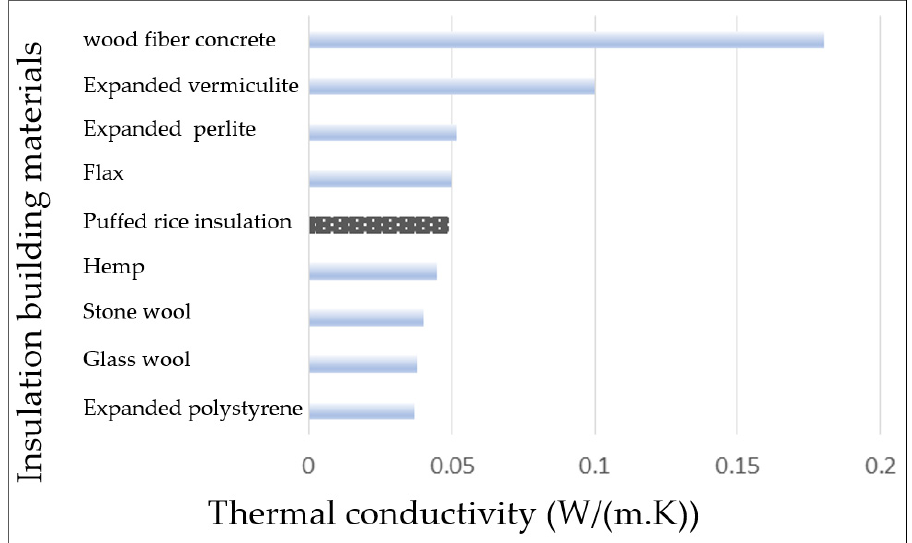
Figure 7. Thermal conductivity comparison between building insulation materials.